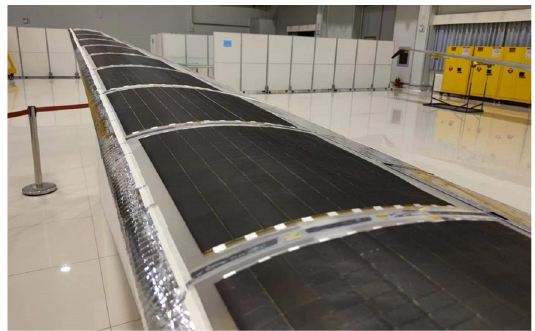
Figure 5. GaAs cells mounted on the UAV.